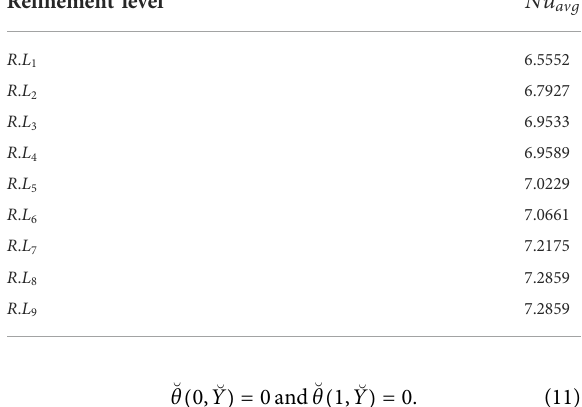
TABLE 2 Grid convergenceanalysisfor the meanNusseltnumber with the fi xed values of Pr (cid:2) 0 . 710 , Da (cid:2) 10 − 3 , andRa (cid:2) 10 3 . Re fi nement